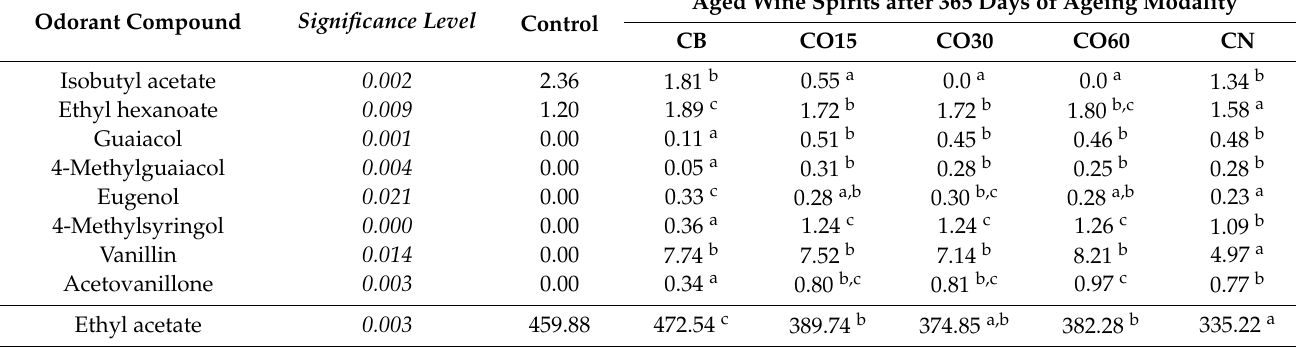
For each compound of aged wine spirit samples, means within the same row followed by different upperrcase letters ( a , b , c ) are significantly different ( p <